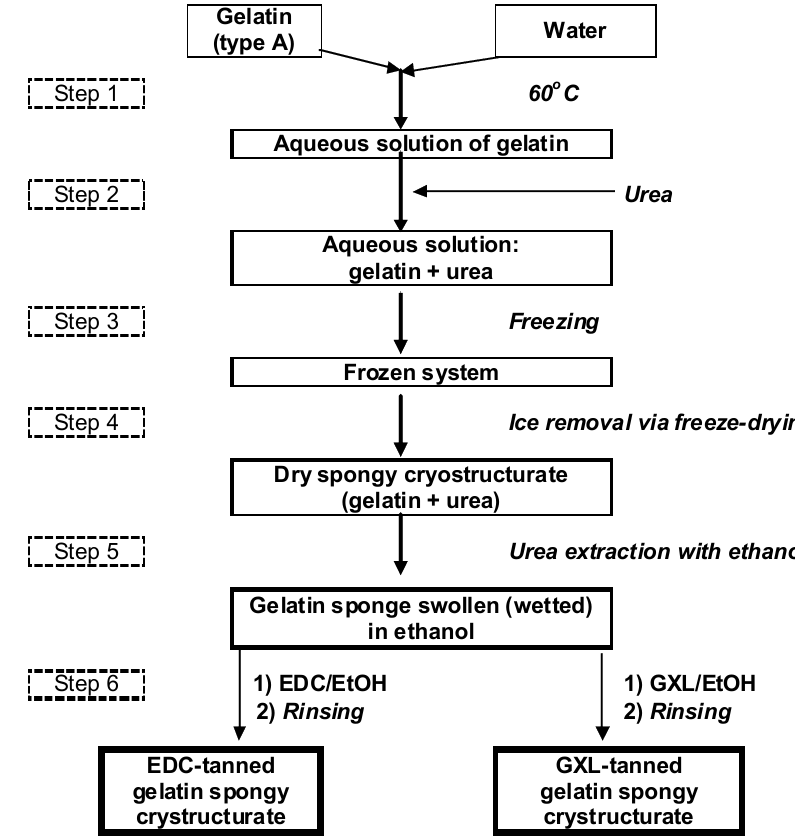
Figure 1. A principal block diagram for the preparation of gelatin